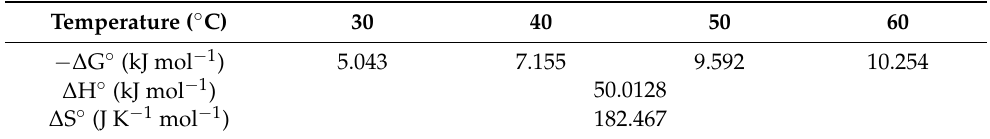
Table 5. Thermodynamics parameters for adsorption of CV onto AISD (experimental